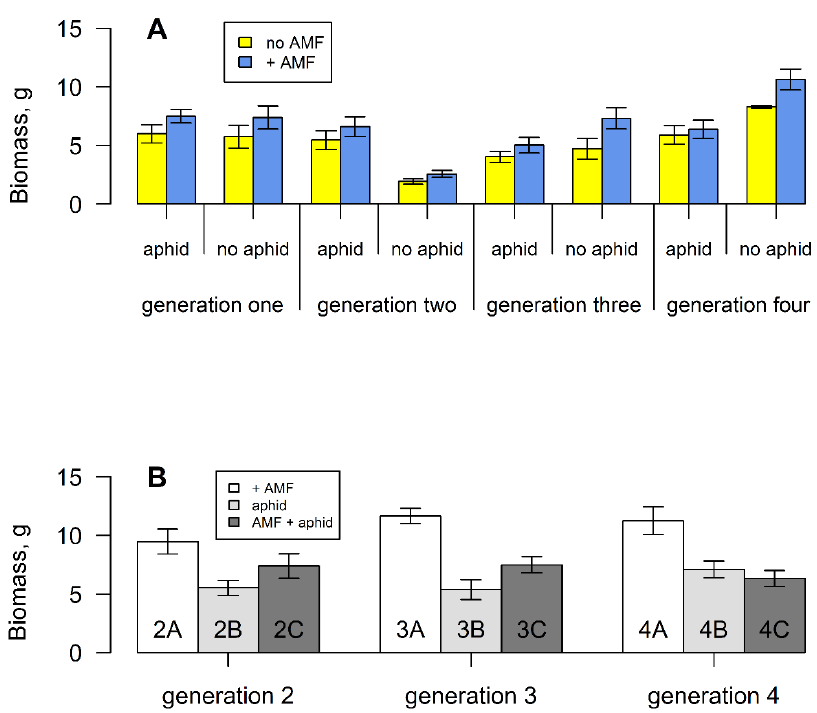
Figure 5. ( A ) Mean total dry biomass of S. vulgaris grown with or without arbuscular mycorrhizal fungi and aphids for four successive generations. Vertical lines represent ± one standard error. ( B ) Mean total dry biomass of S. vulgaris grown without AM fungi, aphids or both, from parents that experienced these treatments (2A, B and C; 3A, B and C and 4A, B and C plants in Figure S1).